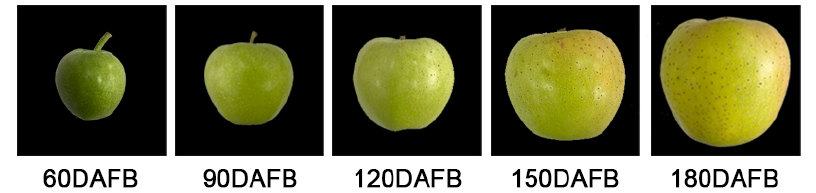
Figure 1. Color development in ‘Orin’ apple skin from 60–180 DAFB.